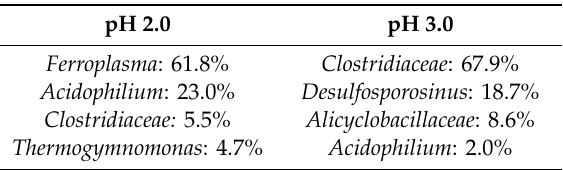
Table 3. Genus of the microbes and their percentage after the anaerobic incubation at pH of 2.0 and 3.0, respectively (percentage >